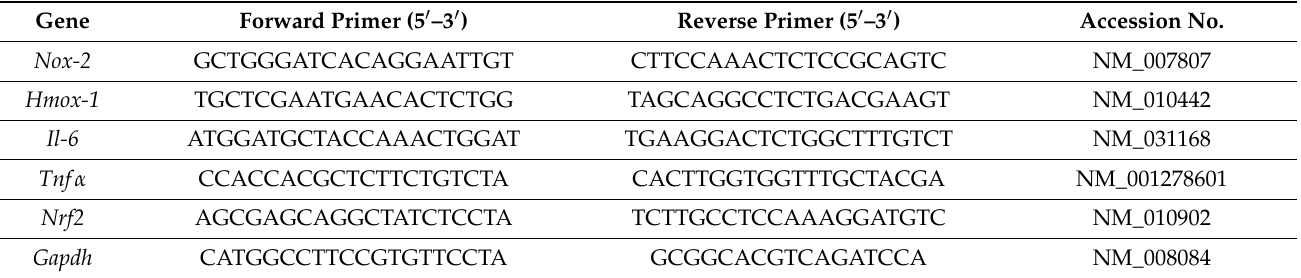
Table 2. Primers used in this study. Annealing temperature was 60 ◦ C for all